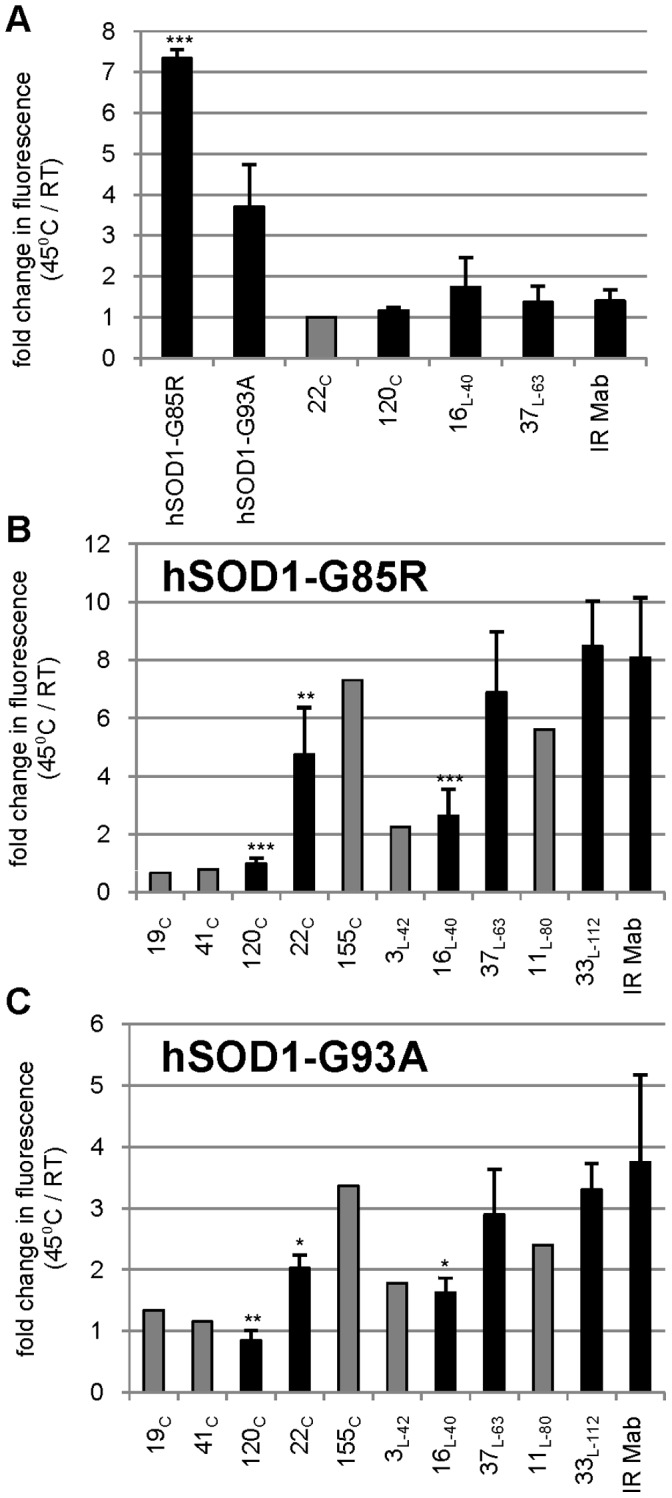
Increased hydrophobicity of hSOD1 can be inhibited by a subset of hSOD1 specific HuMabs.(A) hSOD1-G85R, hSOD1-G93A, various hSOD1-specific HuMabs, and an irrelevant isotype-matched antibody (IR Mab) were separately incubated with 5 mM EDTA at room temperature (RT) or 45°C for 4 hrs. Hydrophobicity was measured with ANS dye fluorescence using a Victor 3 plate reader at 390 nm excitation and 460 nm emission and is reported as the fold change in relative fluorescence units from RT to 45°C. hSOD1-G85R (B) and hSOD1-G93A (C) were mixed with irrelevant antibody or various HuMabs with 5 mM EDTA and incubated at RT or 45°C for 4 hrs. Hydrophobicity was measured as indicated above. The mean of replicates is noted with a thick black bar with the standard deviation indicated. Samples with insufficient material for replicates are indicated with the single data point as a thick grey bar. Statistical significant differences from irrelevant antibody were determined using a Student’s t-test with P<0.01 (***), <0.05 (**), and <0.10 (*) indicated above the black bar for each sample.